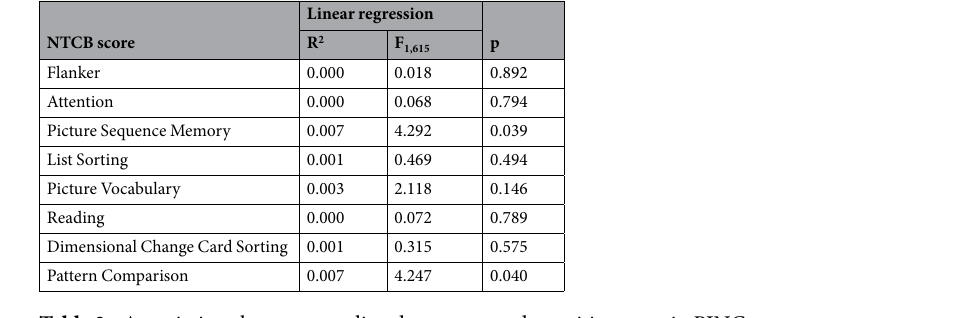
Table 2. Associations between predicted age error and cognitive score in